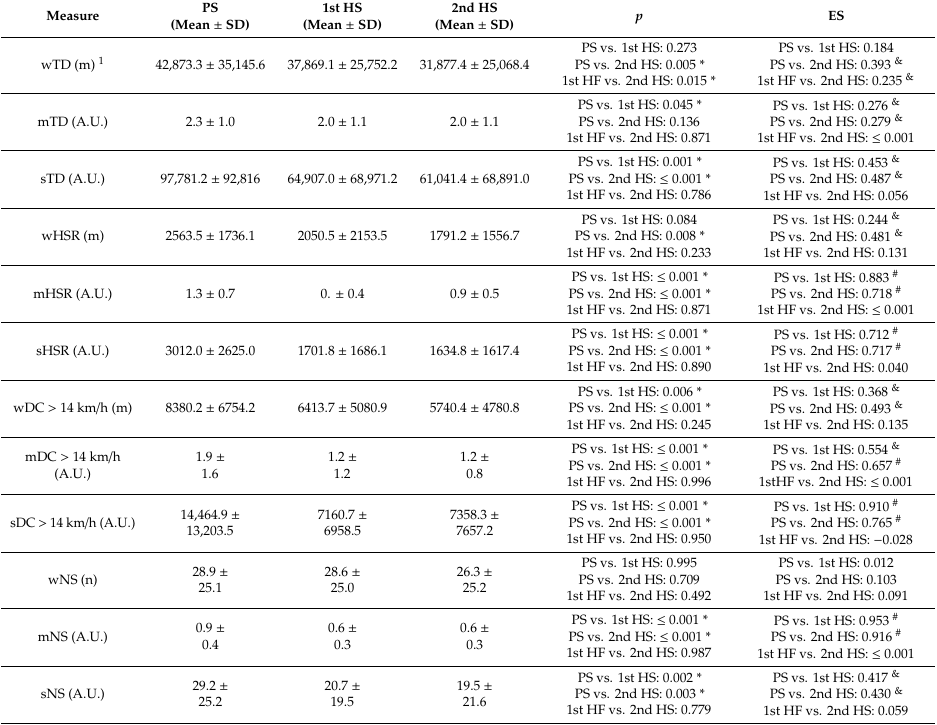
Table 1. Descriptive statistics (mean ± SD) of acute load, training monotony, and training strain for the external load measures in the pre-season, 1st half of the season, and 2nd half of the season.